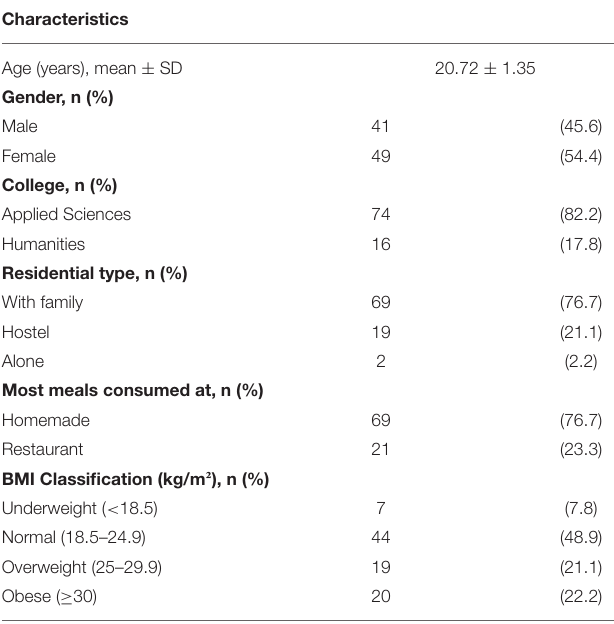
TABLE 1 | Characteristics of the study participants ( N =